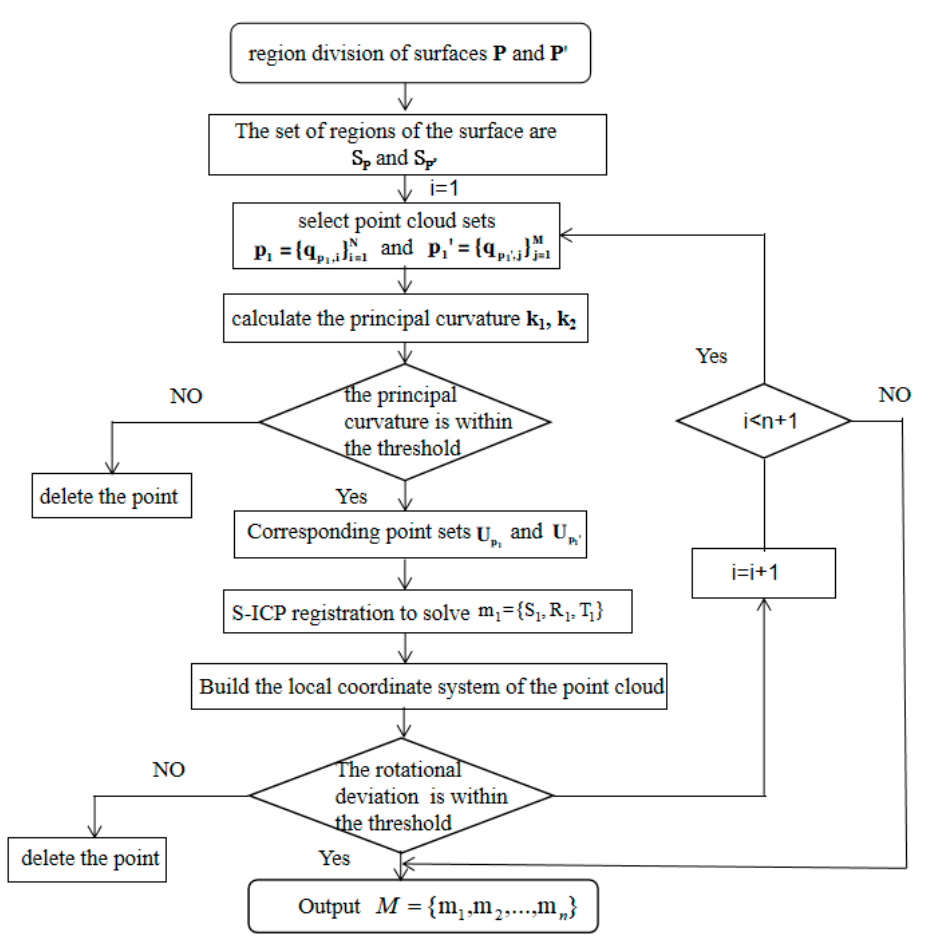
Figure 3. Flow chart of